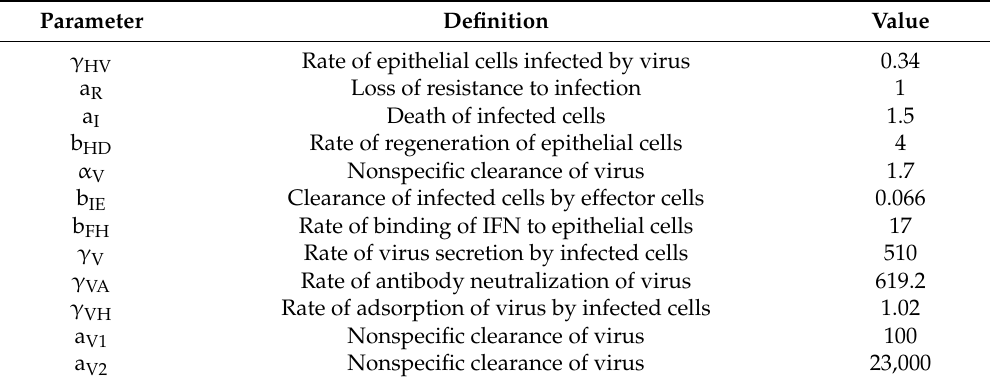
Table A3. Parameter definitions and values for the Hancioglu